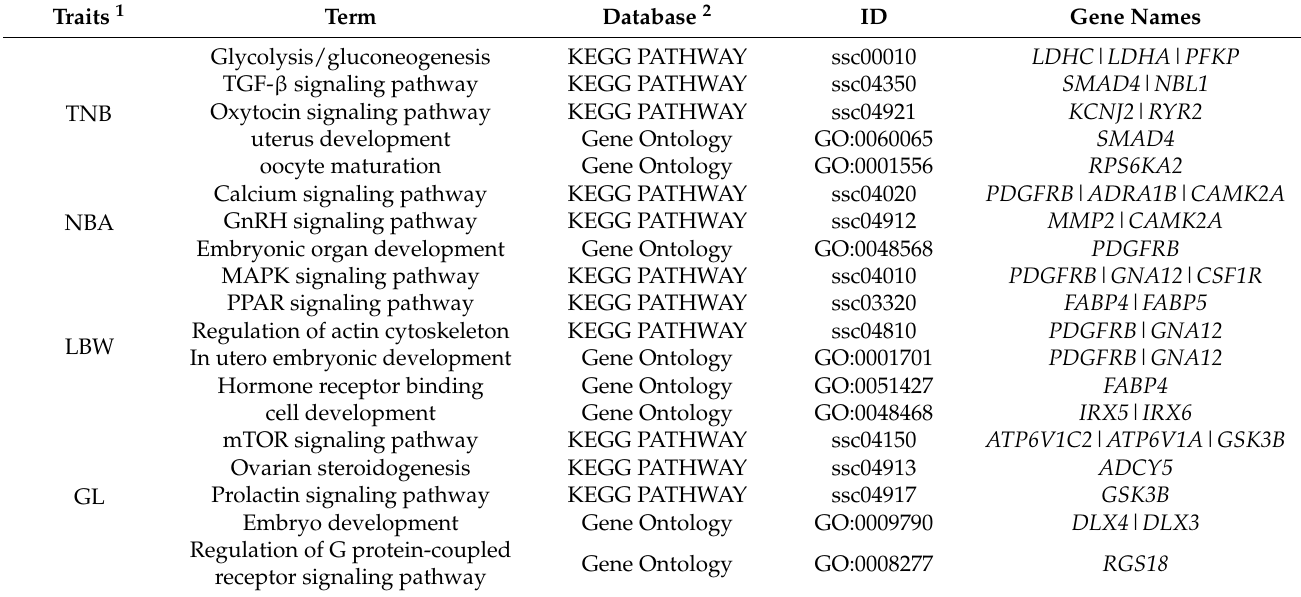
Table 7. Significant KEGG pathways and GO terms associated with productive traits in pigs ( p <